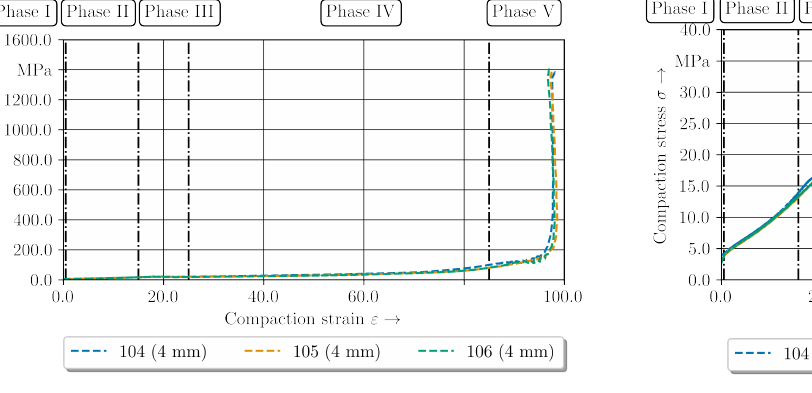
Figure 19. Experimental stress compaction curves of the 2 mm—configuration for 200°C up to a compaction force of 200kN ( a ) without friction compensation ( b ) with friction compensation according to